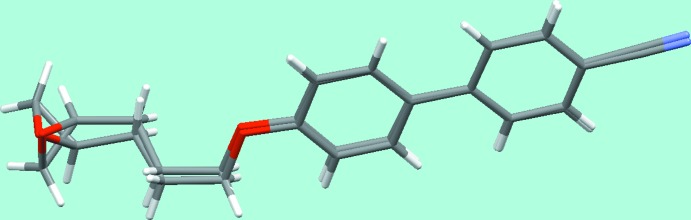
One mol­ecule of the asymmetric unit overlaid with best fit on an inverted form of the other mol­ecule.